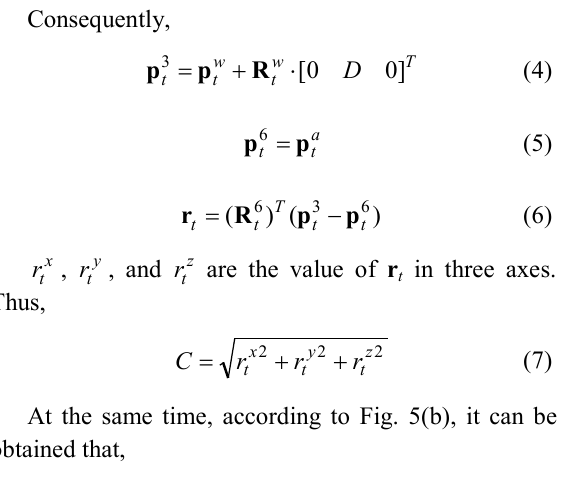
Fig. 5. Diagram of space pose. (a) Space pose of one leg. (b) Space pose of knee. (c) Space pose of